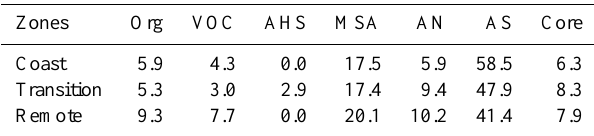
Table 3. VACC zonal mean particle number concentration for the identified chemical compounds. Concentrations are expressed as percentage of the integrated number concentration in the diameter range